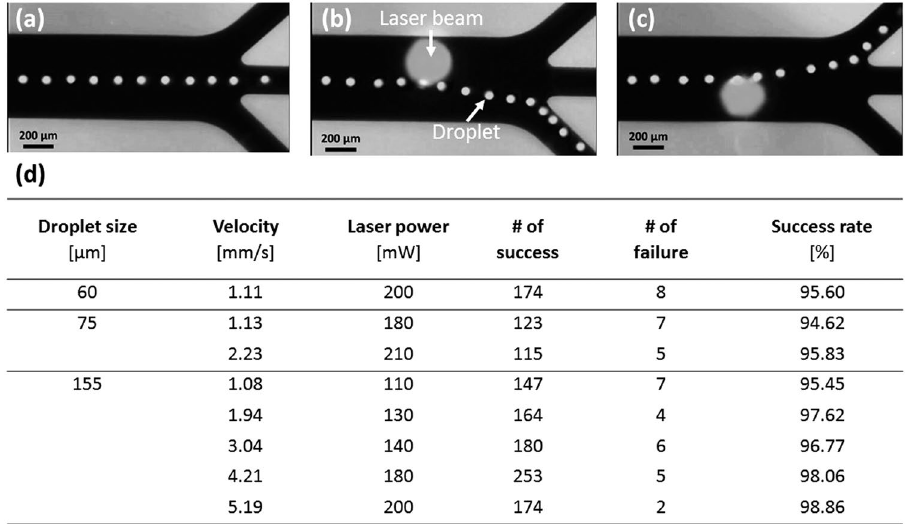
Figure 4. On-demand droplet routing results. Overlapping images of droplet movements ( a ) without laser beam irradiation, ( b ) with laser beam irradiation on the upper side, and ( c ) with laser beam irradiation on the lower side of the droplet trajectory. ( d ) Success rates and flow conditions of on-demand droplet